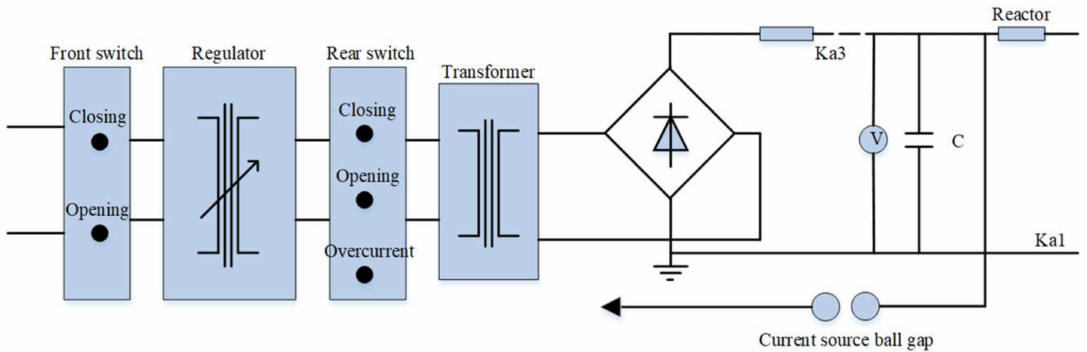
Figure 10. Fuse breaking test schematic